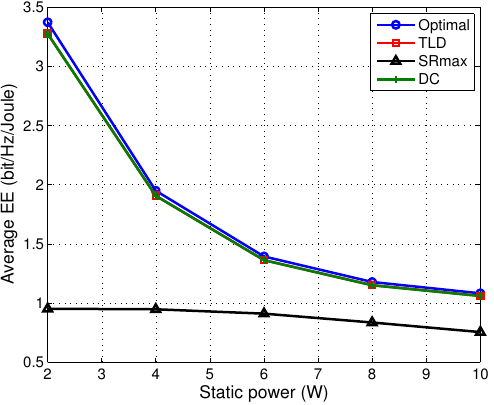
Figure 7. Average EE versus static power with P m = 30 dBm and C = 5 bits/s/Hz.